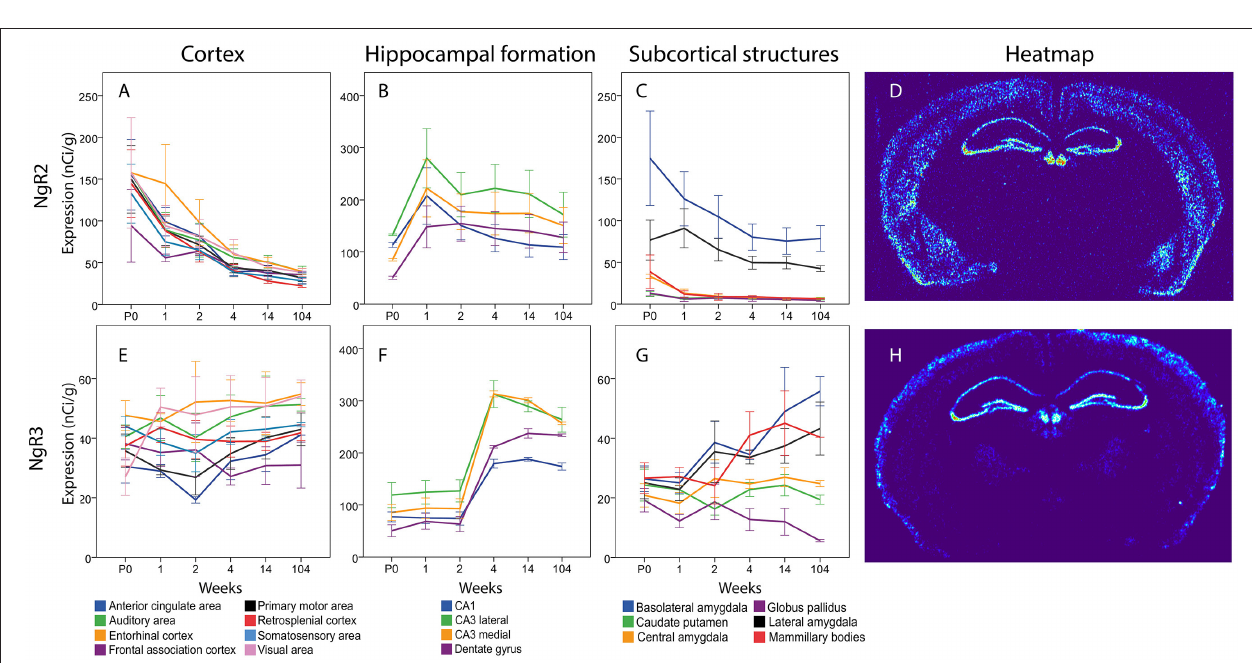
FIGURE 12 | Graphs showing the mRNA expression for NgR2 (A–C) and NgR3 (E–G) in the 18 cerebral regions over time. For full legend see Figure 9. Heatmaps of the two genes (D,H) visualizing expression in 14 week old mice.